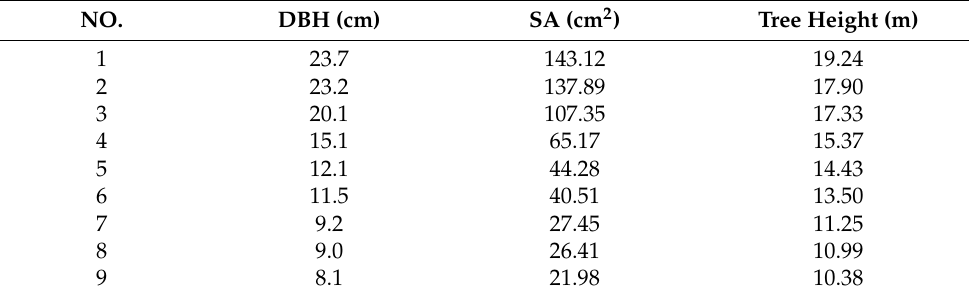
Table 2. Detailed information of sample trees for sap flow